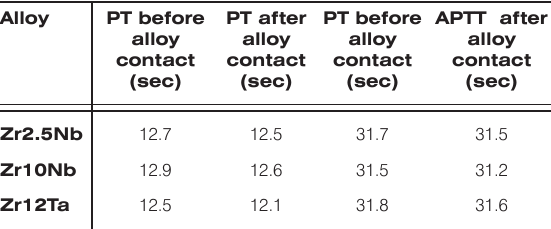
Table 3. Clotting time (PT and